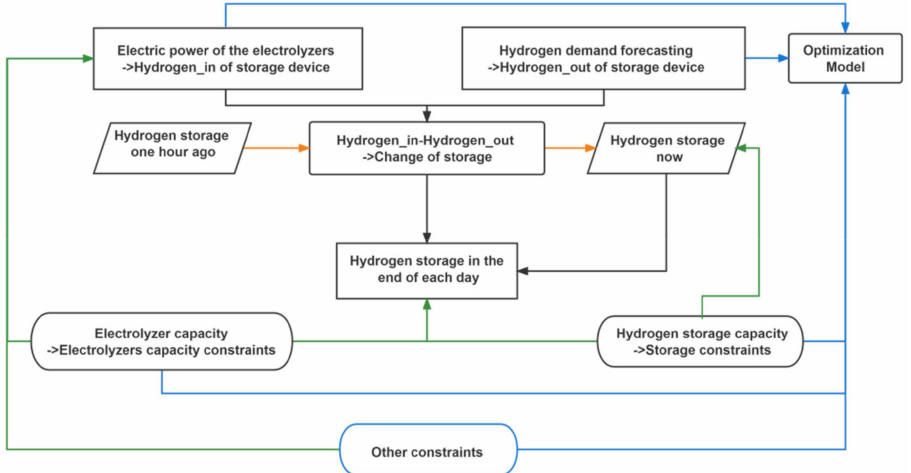
Figure 7. The algorithm for the proposed optimization